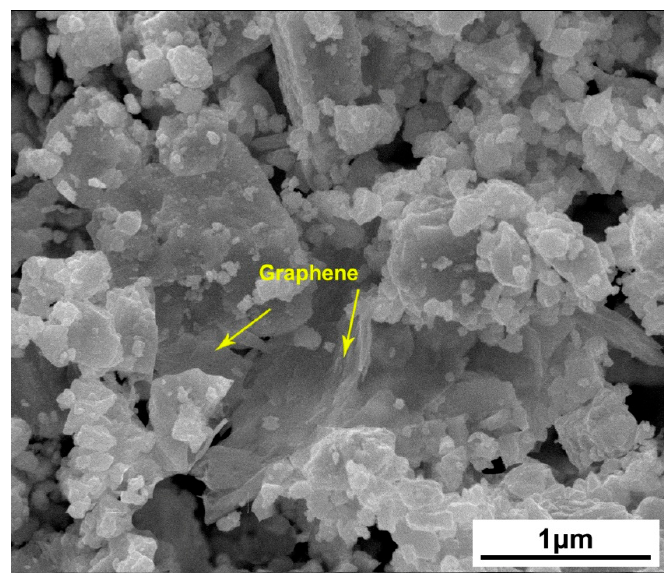
Figure 2. SEM image of the 1.0 vol % graphene/Cu 2 SnSe 3 powder after ball milling.